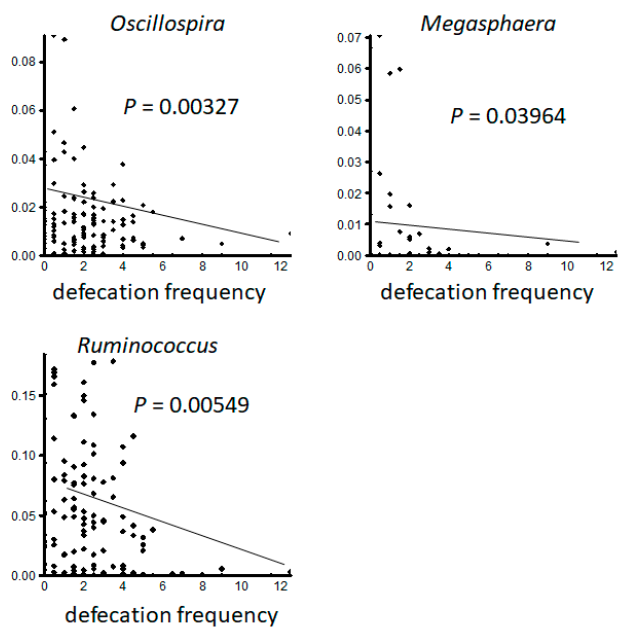
Figure 6. The defecation frequency negatively correlates with the frequency of order Clostridiales - belonging bacteria in gut microbiome. The defecation frequency was cross-analyzed with the taxonomy data obtained above and found to correlate negatively with the frequency of some bacteria belonging to the order Clostridiales , such as genus Oscillospira , Megasphaera , and Ruminococcus .